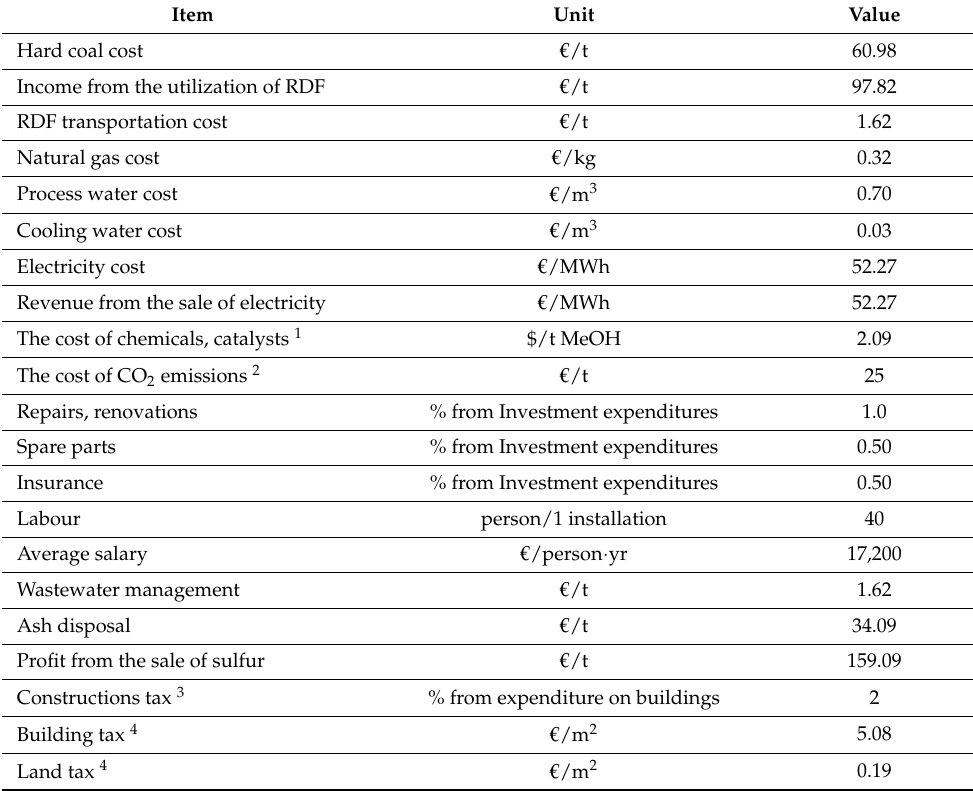
Table 8. Assumptions for estimating production